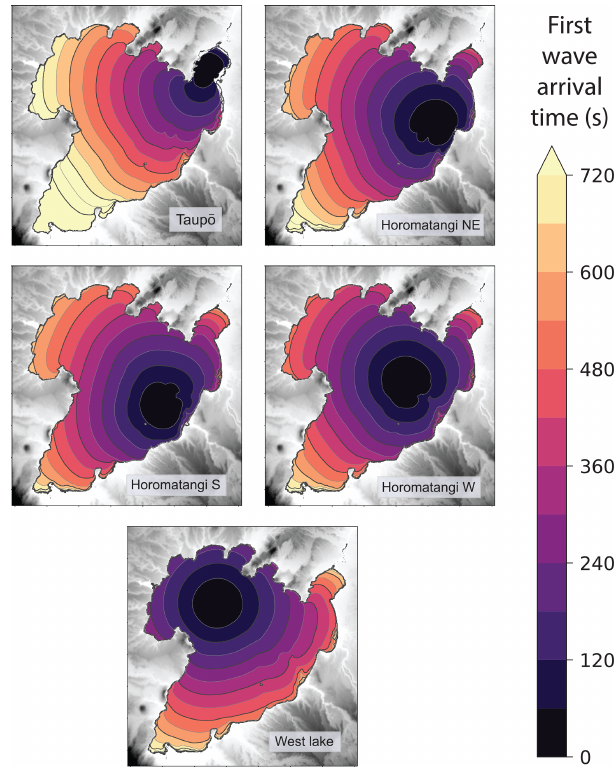
Figure 7. First wave arrival times for each source location. Contours are plotted at each